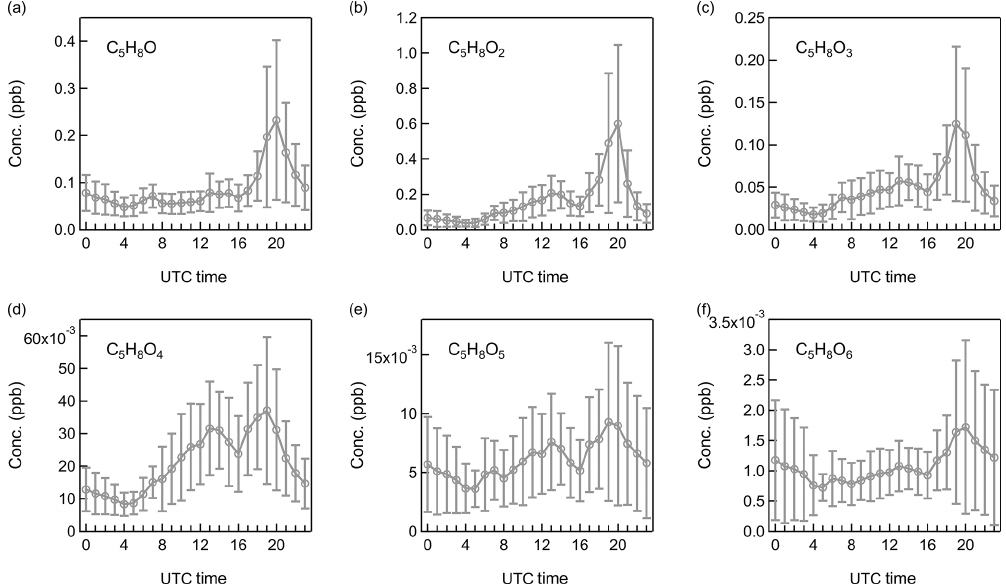
Figure 7. Diurnal patterns of non-nitrate isoprene oxidation products: (a) C 5 H 8 O, (b) C 5 H 8 O 2 , (c) C 5 H 8 O 3 , (d) C 5 H 8 O 4 , (e) C 5 H 8 O 5 , and (f) C 5 H 8 O 6 .